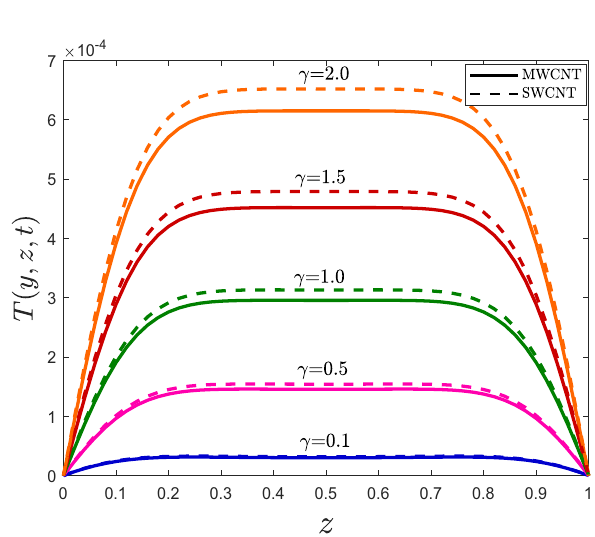
Figure 8. One-dimensional temperature profile for different values of γ